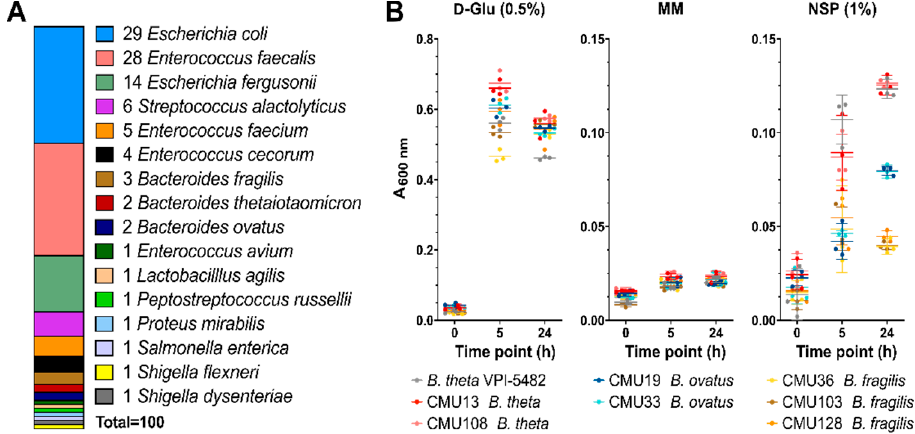
Figure 5. Identification and characterization of bacterial CM NSP degraders. ( A ) 16S rDNA sequencing was performed to identify the 100 bacterial species obtained from isolation plating bioreactor samples on CM NSP. Of those bacterial samples, Bacteroides isolate growth was assayed ( B ) in liquid minimal media containing 0.5% D-Glu (positive control), no carbohydrate (MM) (negative control), or 1% CM NSP. Background data was subtracted for media containing no bacterial culture inoculate. Error bars represent the SEM from triplicate data. Liquid culture bacterial isolates are coloured as